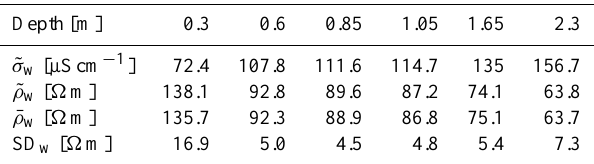
Table 2. Median pore water conductivity ˜ σ w , resistivity ˜ ρ w and mean resistivity ¯ ρ w with standard deviation (SD w ) per depth ( n ≥ 11 per sampling